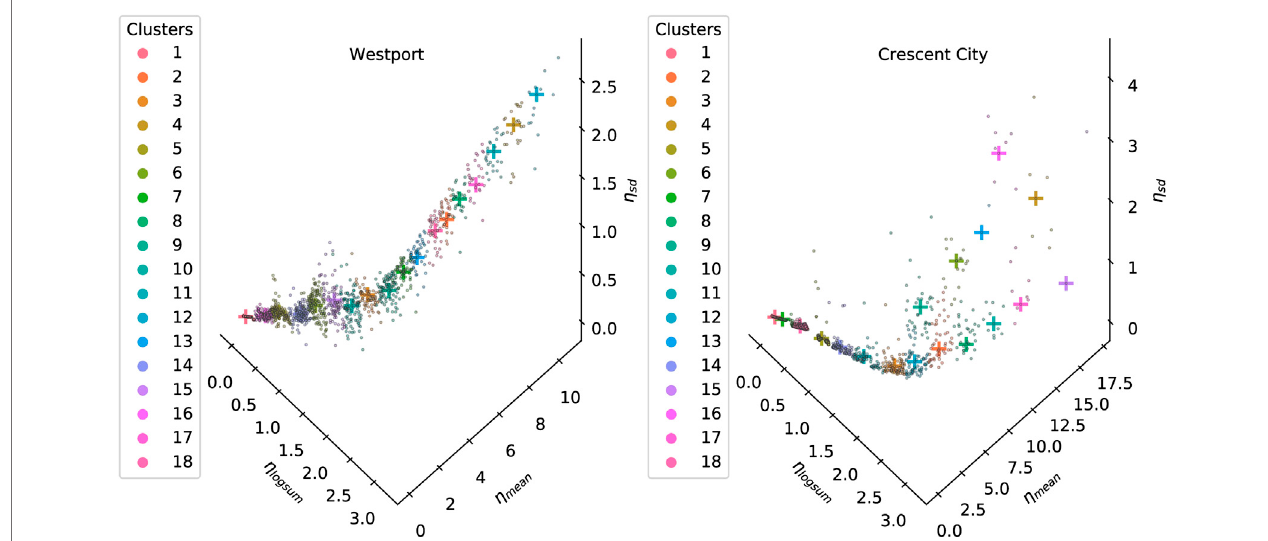
FIGURE 9 | Clustering results for the two study regions. In each case all 2,000 realizations are represented as a point in the three-dimensional proxy-space, and colored by cluster after with 18 clusters in each case. The crosses indicate the cluster representative, i.e., the realization closest to the centroid of each cluster.